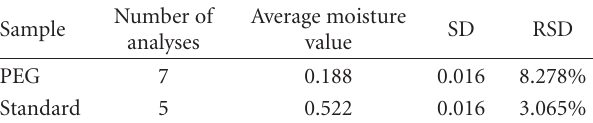
Table 4: Accuracy of moisture determination with the original method with visual observation of the